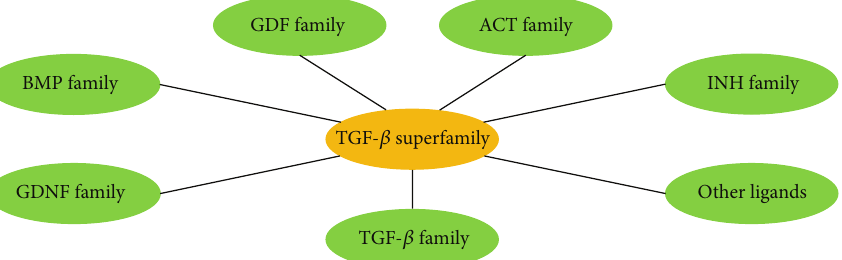
Figure 1: A schematic representation of TGF- 𝛽 superfamily. TGF- 𝛽 : transforming growth factor beta; GDF: growth and differentiation factor; ACT: activin; INH: inhibin; other ligands include M¨ullerian inhibiting substance (MIS) or anti-M¨ullerian hormone (AMH), left- right determination factor (Lefty), and nodal growth differentiation factor (Nodal); GDNF: glial-derived neurotrophic factors; BMPs: bone morphogenetic